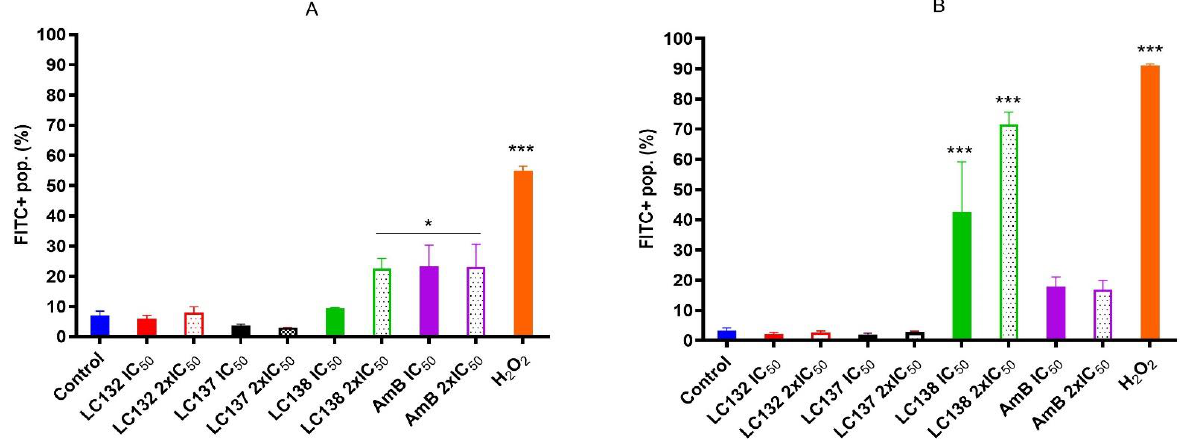
Figure 3. Effect of LC132, LC137, LC138 and AmB IC 50 (13.0 µM, 137.0 µM, 125.4 µM and 0.2 µM, respectively) and 2 × IC 50 (25.9 µM, 274.0 µM, 250.8 µM and 0.4 µM, respectively) on generation of ROS in L. infantum promastigotes, after ( A ) 5 h and ( B ) 24 h incubation. Parasites were labelled with CM-H 2 DCFDA. H 2 O 2 (1 mM) was used as positive control. Data are represented by mean percentage of positive populations of FITC population ± SEM of three experiments, with triplicates. Asterisks represent statistically significant differences of treated, related to non-treated control * p < 0.01, *** p < 0.0001.